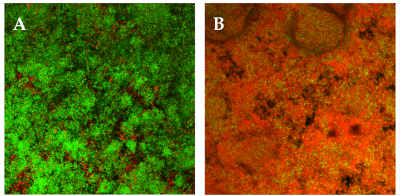
Figure 6. Confocal laser scanning microscopy (CLSM) of multi-species biofilms formed by S. mutans, S. gordonii , and S. sanguinis exposed to the negative control or treated with LTP for 120 s; 25X 0.95 zoom. Biofilms are stained with Live/Dead BacLight Viability kit. Live cells are in fluorescent green (SYTO 9) and dead cells in fluorescent red (propidium iodide). (A) Negative control (NC), live/dead overlaid images and (B) LTP for 120 s (P120, live/dead overlaid